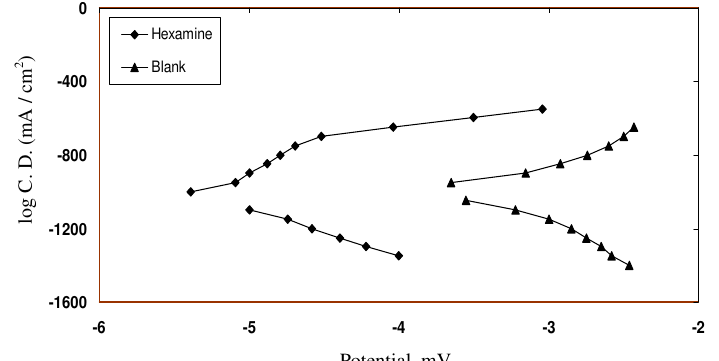
Figure 1 . Plot of log( θ /1- θ ) versus log C for hexamine in 0.01 M phosphoric acid concentration